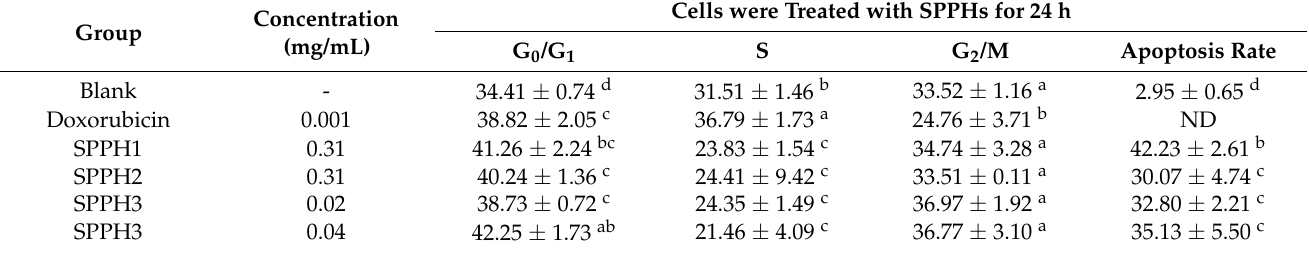
Table 1. Effects of different concentrations of SPPHs on cycle distribution and apoptosis rate on MGC-803